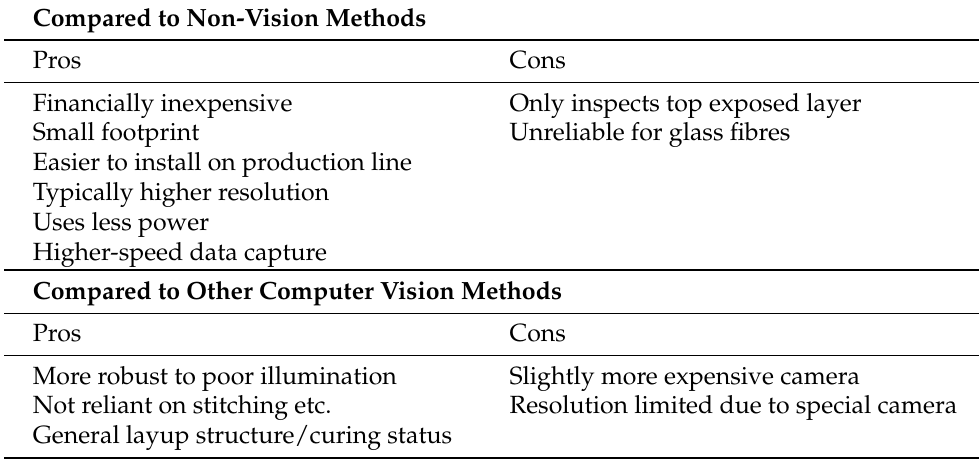
Table 1. Pros and cons of polarisation vision for CFRP inspection compared to alternative